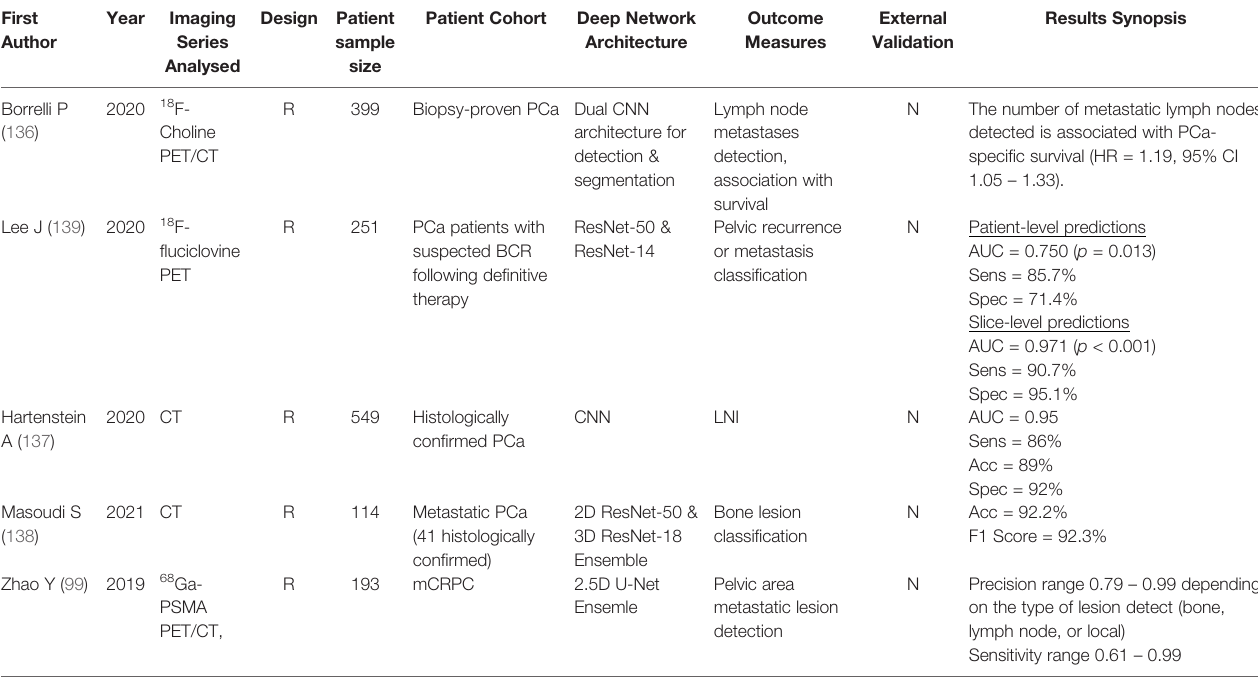
TABLE 6 | Prominent characteristics of identi fi ed mPCa papers using deep radiomics methodology on PET and/or CT